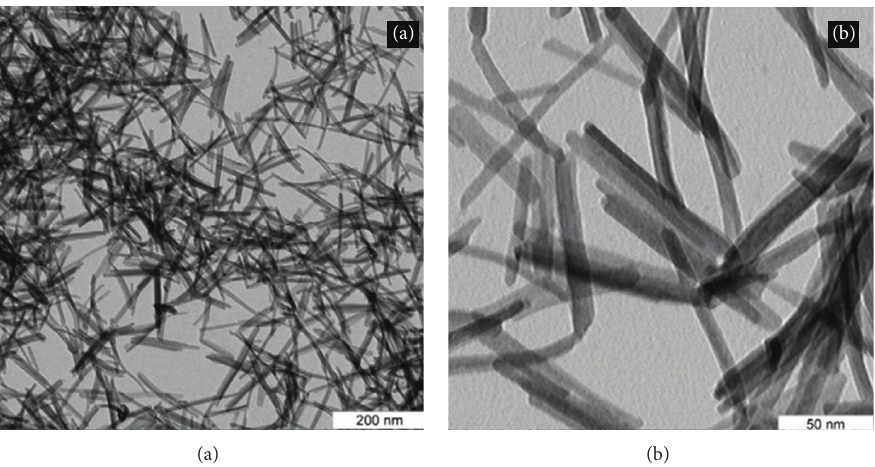
Figure 1: The typical TEM images of the La(OH) 3 nanorods [13].